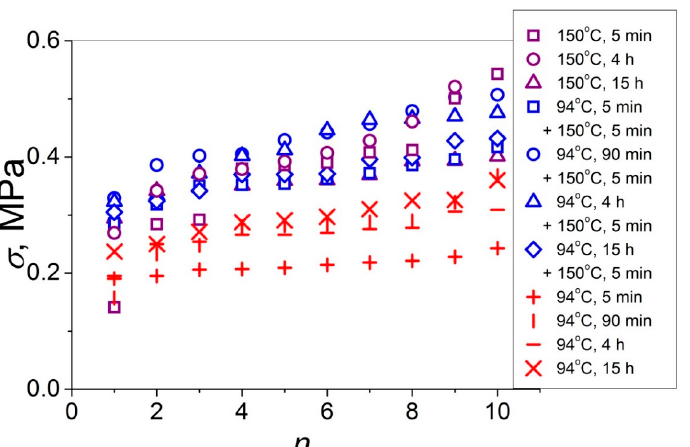
Figure 2. Lap-shear strength σ , shown as a function of the joint number in ascending order, that developed at several symmetric PET–PET interfaces: (crosses and dashes) amorphous interface self- healed at T = 94 °C for t = 5 min to 15 h, (open blue symbols) amorphous interface self-healed at T = 94 °C for t = 5 min to 15 h and submitted thereafter to self-healing and cold crystallization at T = 150 °C for t = 5 min, and (open purple symbols) amorphous interface submitted to self-healing and cold crystallization at T = 150 °C for t = 5 min to 15 h. The 11 data sets presented in Figure 2 were investigated regarding their conformity to both the normal and Weibull’s distributions. For this purpose, the following four plot types were constructed (see Figures 3–13): (a) Weibull’s plots lnln[1/(1 − Р j )] vs. ln σ , (b) normal probability plots (normal percentiles (NP) vs. σ ), (c) probability density function (PDF) vs. σ , and (d) quantile–quantile (Q–Q) plots (expected normal value vs. measured value; only in Figure 3d). The results of this analysis for self-bonding at (i) T = 94 °C, (ii) T = 94 °C followed by T = 150 °C, and (iii) T = 150 °C are presented in Figures 3, 4, 5, 6, Figures 7, 8, 9, 10, and Figures 11, 12, 13, respectively. ( a )